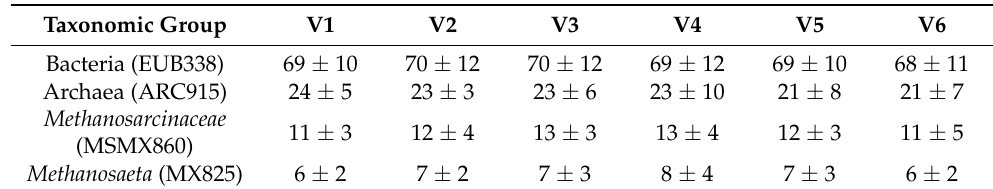
Table 4. Microbial taxonomy in particular experimental